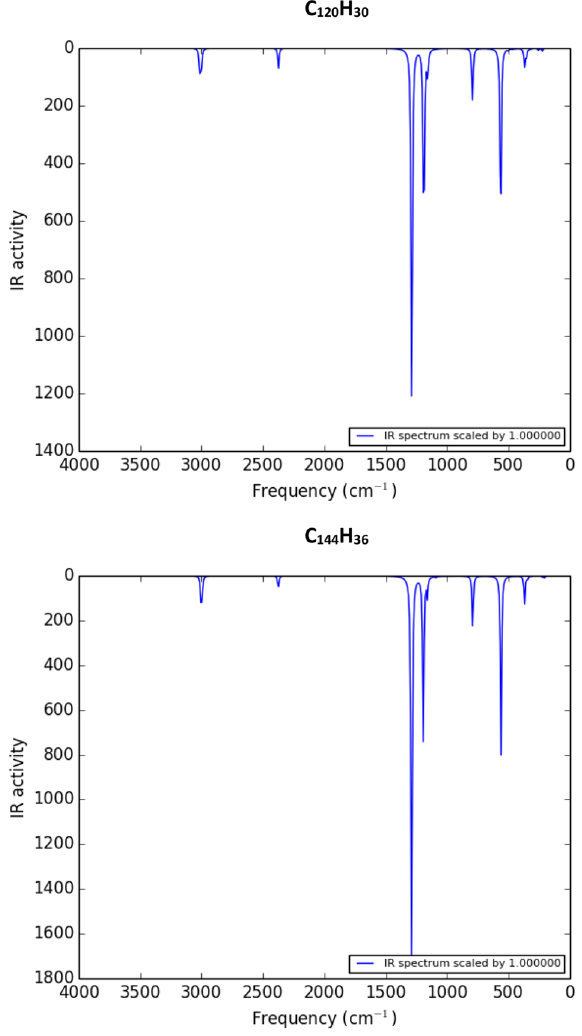
Figure 3. The infrared spectra for the fullerynes, C 120 H 30 and C 144 H 36